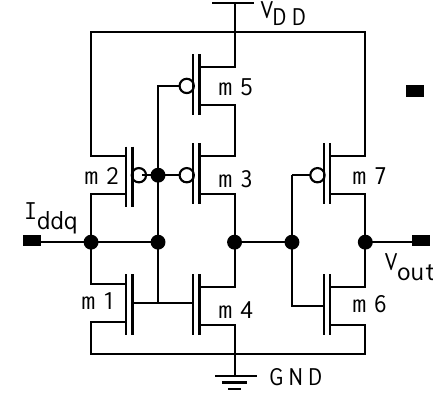
Figure 5. Proposed NBTI sensor circuit.